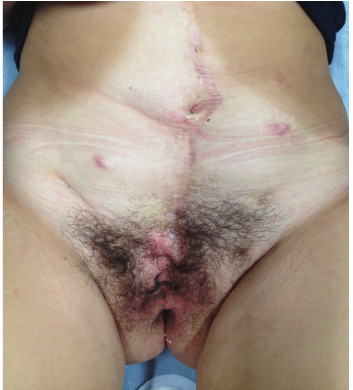
Figure 1: Abdomen examination.